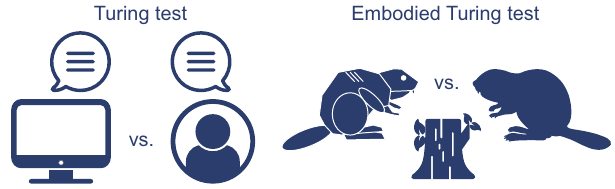
Fig. 1 | Turing tests: comparisons between the performance of AI systems and their living counterparts. Left : The original Turing test as proposed by Alan Turing 25 . If a human tester cannot determine whether their interlocutor is an AI system or another human, the AI passes the test. Modern large language models have made substantial progress towards passing this test 26 . Right : The embodied Turingtest.AnAIanimalmodel — whetherroboticorinsimulation — passesthetestif its behavior is indistinguishable from that of its living counterpart. No AI systems are close to passing this test. Here, an arti fi cial beaver is tested on the species- speci fi c behavior of dam